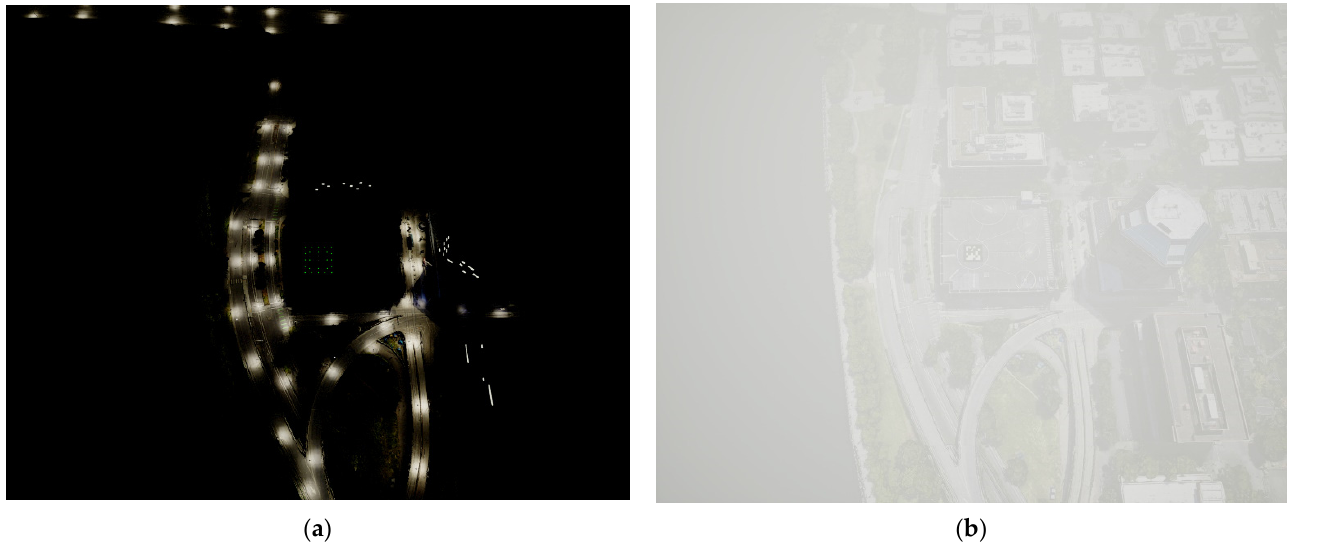
Figure 8. ( a ) UE4 reproduction of Portland heliport and its surroundings at night; ( b ) UE4 reproduction of Portland heliport and its surroundings with fog.